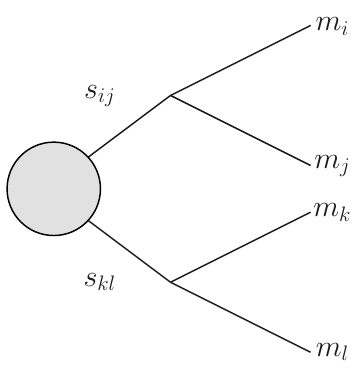
Figure 3 . Final-state topology of a doubly resonant diagram for the production of the particle pairs ( i; j ) and ( k; l